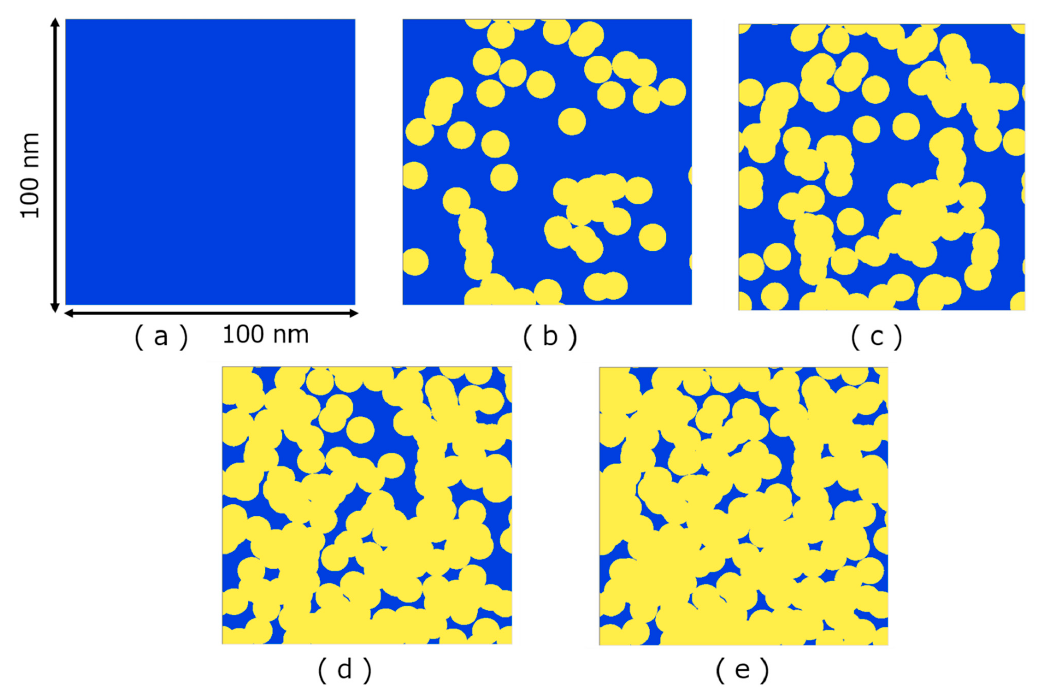
Figure 1. Two-dimensional images of amorphized (yellow) and non-amorphized (blue) areas for various ion fluences; ( a ) 0 cm 2 (unirrradiated), ( b ) 5 × 10 11 cm 2 , ( c ) 1 × 10 12 cm 2 , ( d ) 2 × 10 12 cm 2 and ( e ) 2.5 × 10 12 cm 2 . The diameter of ion track is assumed to be 9.6 nm.